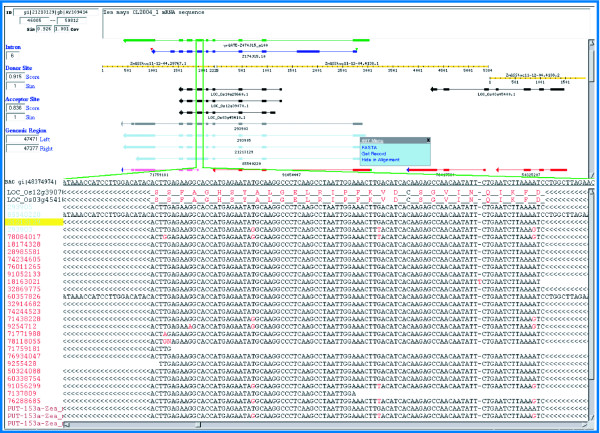
A ZmGDB transcript view context page associated with the genomic region depicted in Figure 1. The feature graphic in the top window pane is described in Figure 1. Information at the top and left of this pane is displayed when passing the cursor over feature elements. Currently displayed is the information associated with the sixth intron (immediately left of the green viewfinder) of the GeneSeqer spliced alignment of a Zea mays cDNA sequence (accession AV109414, GenBank id 21213129). The vertical green bars represent the view finder for the sequence view found in the bottom window pane. Red nucleotides shown in this view represent alignment mismatches with the genomic sequence.